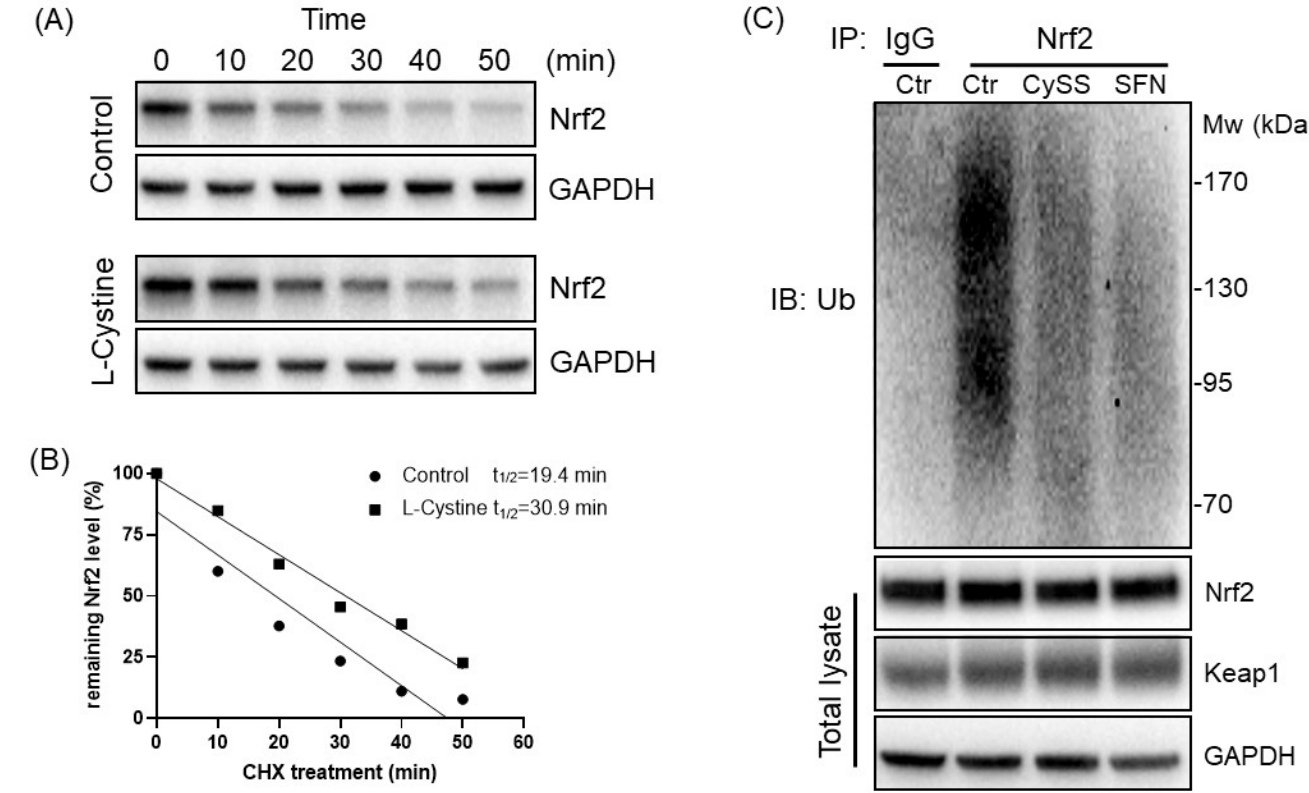
Figure 10. L-Cystine Extends the Half-Life of the Nrf2 Protein and decreases Nrf2 ubiquitylation. HeLa cells were treated with 0 (control) or 0.8 mM L-Cystine for 4 h followed by treatment of 100 µ g/mL cycloheximide (CHX) for the indicated time. Cells were harvested at the end of the time points for detection of Nrf2 protein by Western Blot, using GAPDH as a loading control ( A ). The relative Nrf2 expression was plotted over time after adding CHX for the calculation of the half-life by linear regression ( B ). HeLa cells were treated with 0.8 mM L-Cystine (CySS) or 5 µ M SFN in the presence of 10 µ M MG132 for 4 h. Nrf2 protein was immunoprecipitated from cell lysate with an anti-Nrf2 antibody and resolved in 5% SDS-page gel for detection of ubiquitin by immunoblotting ( C ). Endogenous Nrf2, Keap1 and GAPDH from MG132-treated cells were included as a loading control ( C ).